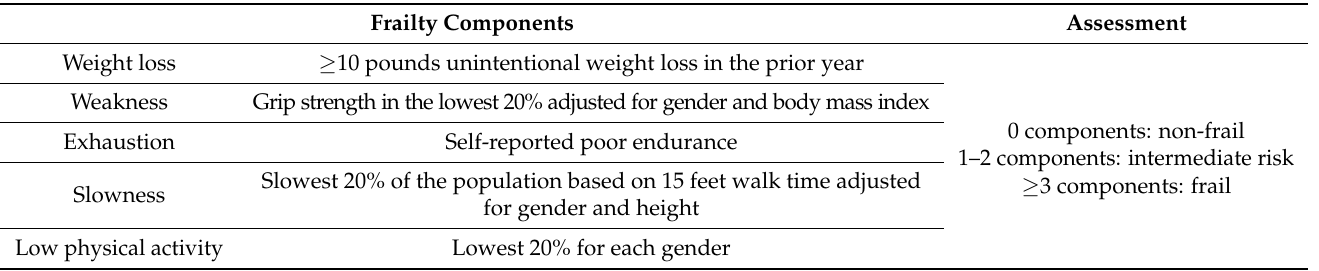
Table 1. Fried Frailty Criteria [72]. Frailty